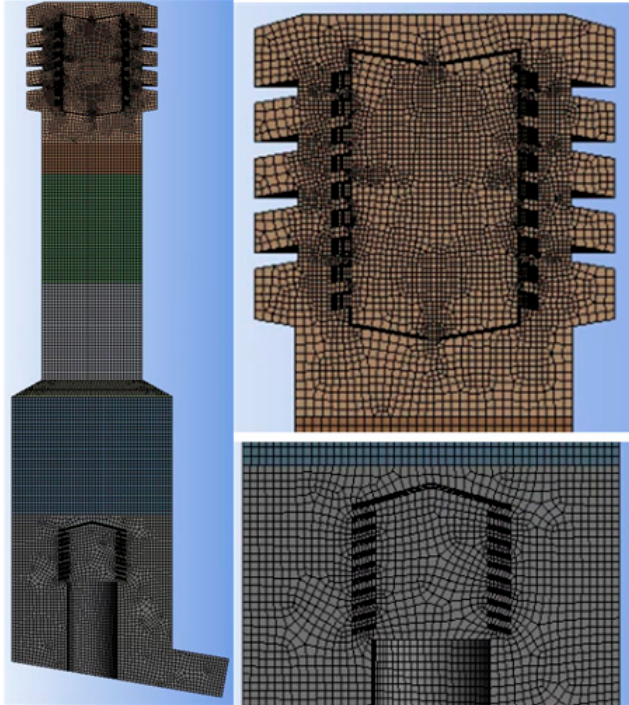
Figure 3. Mesh for acoustics calculation.